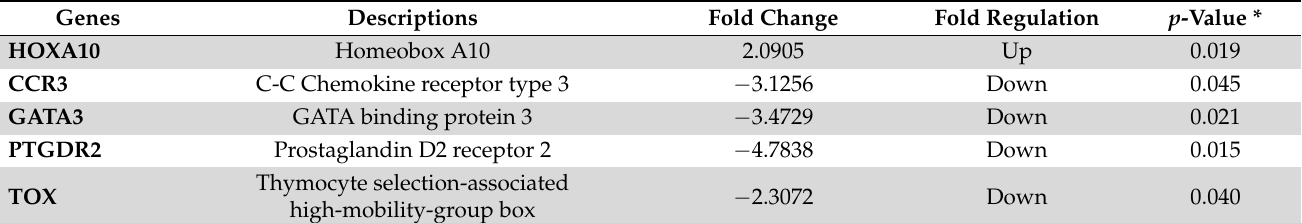
Table 6. Dysregulated genes in the T-helper cell differentiation array compared with normal controls.